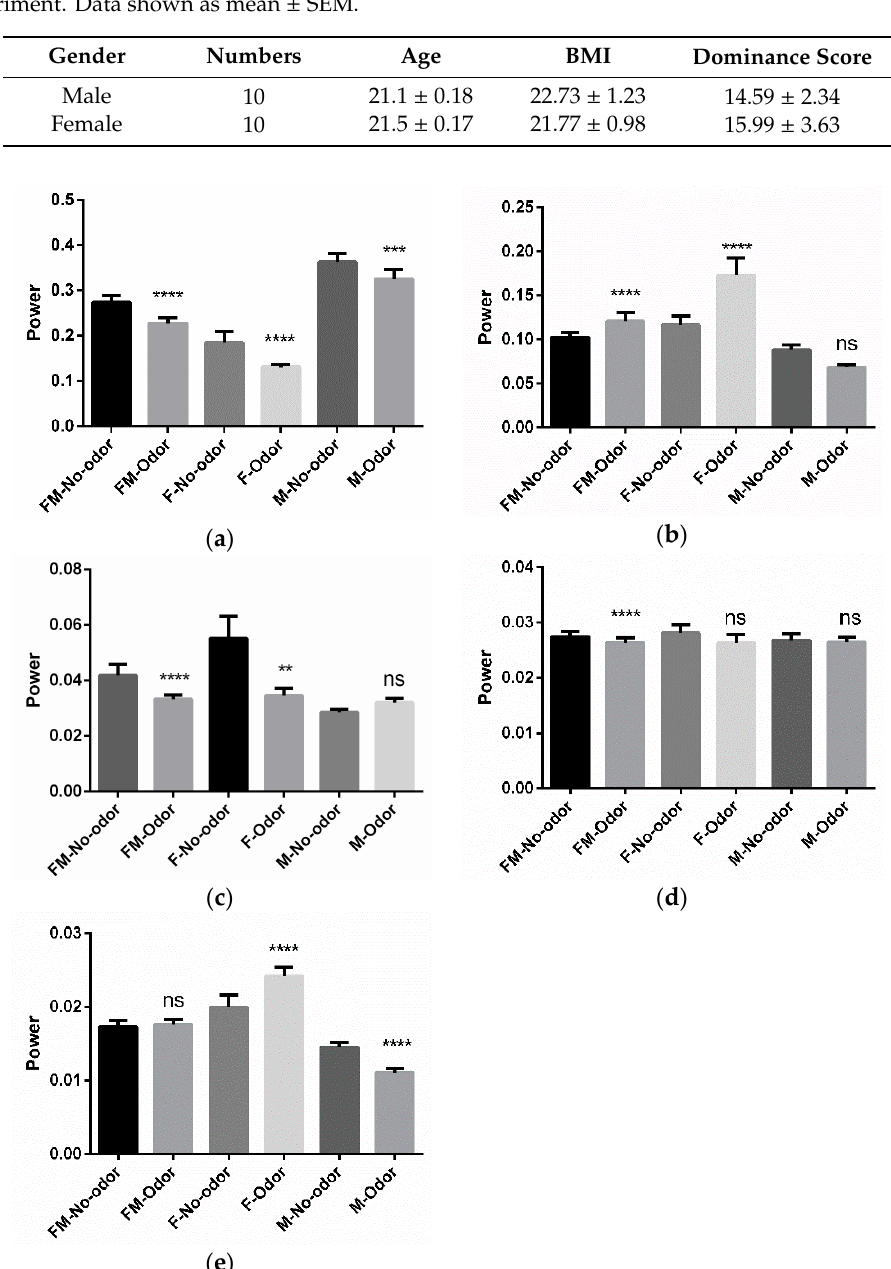
Table 1. Baseline characteristics of female and male subjects involved in the michelia oil inhalation experiment. Data shown as mean ± SEM.